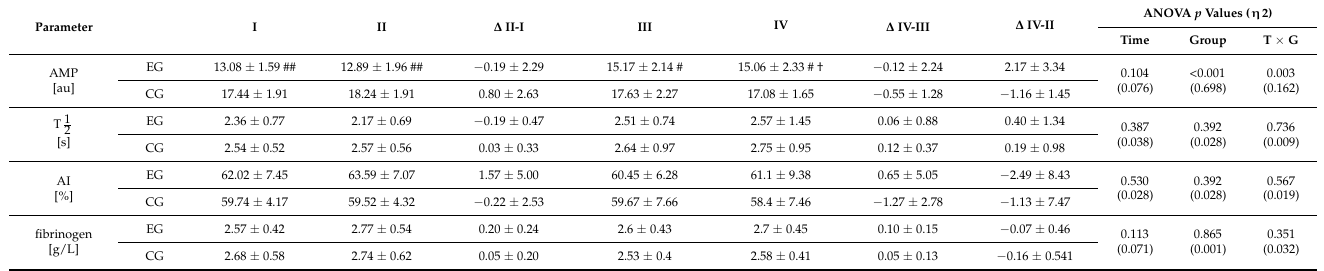
Table 5. Changes in aggregation indices and fibrinogen concentration after a single bout of exercise in experimental (EG) and comparison group (CG).